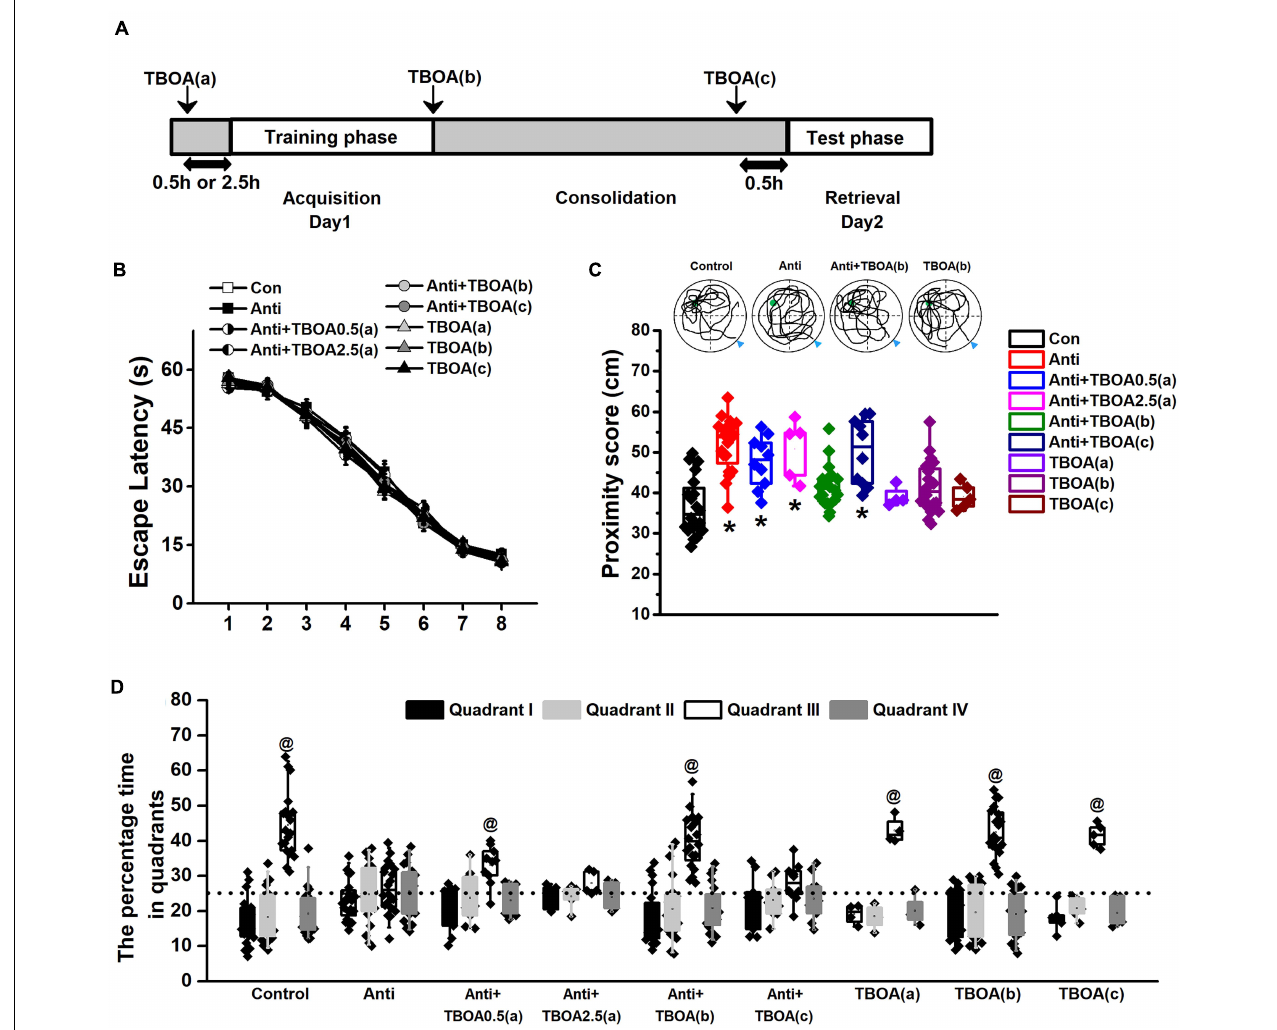
FIGURE 4 | Activation of GluN2B can rescue memory consolidation induced by blocking postnatal proBDNF. The infusion of TBOA was conducted 0.5 (Anti+TBOA0.5(a)) or 2.5 h (Anti+TBOA2.5(a)) before spatial training (acquisition), immediately following training (consolidation; Anti+TBOA(b)), and 30 min prior to probe memory test (retrieval; Anti+TBOA(c)), respectively. (A) Schematic description of the experimental timeline. (B) Escape latency in the training phase and (C) the swim proximity score during the probe trial. Note the sample swimming traces demonstrating the swimming trajectories of the control, Anti+TBOA(b), and TBOA(b) groups rather than the Anti group superimposed on target quadrant. The triangle indicated the start point during probe trial. (* p < 0.05, vs. control, Anti+TBOA(b), TBOA(a), TBOA(b), or TBOA(c)). (D) The percentage of time spent in each quadrant during the probe test. @ p < 0.05, vs. other quadrants. Note the data from rats (control, Anti, Anti+TBOA(b), and TBOA(b) groups) used in the single-unit recording were included. n = 20 for the control, Anti, Anti+TBOA(b), and TBOA(b) groups, n = 10 for the Anti+TBOA0.5(a) and Anti+TBOA(c) groups, n = 5 for the Anti+TBOA2.5(a) group, n = 4 for the TBOA(a) group, and n = 5 for the TBOA(c)